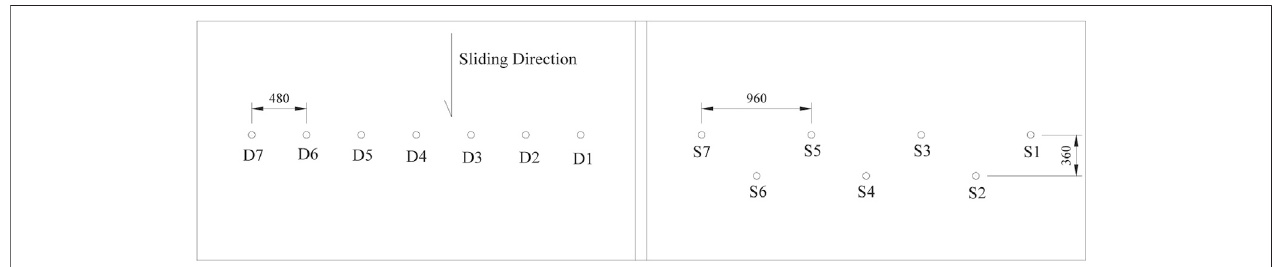
FIGURE 3 | Plain view of the models for two con fi gurations: single row and double rows (unit: mm).